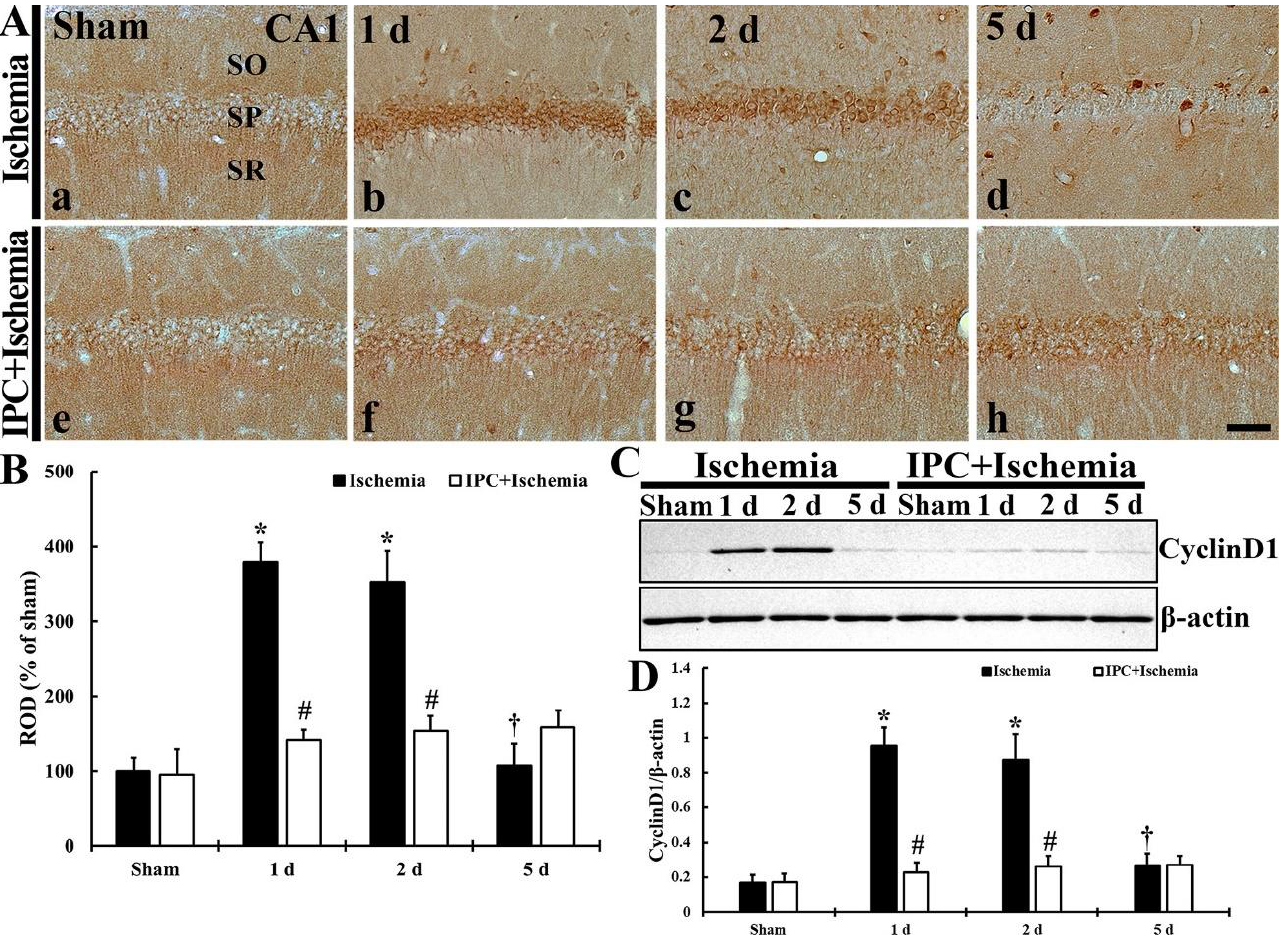
Figure 3. ( A ) Immunostaining of cyclin D1 in CA1 of the TI (upper column) and IPC+TI (lower column) groups at sham (a,e), 1 day (b,f), 2 days (c,g), and 5 days (d,h) after TI. Cyclin D1 immunoreactivity is increased in pyramidal cells located in the stratum pyramidale (SP) at 1 and 2 days after TI. In the IPC+TI group, cyclin D1 immunoreactivity is similar to that found in the sham group. SO, stratum oriens; SR, stratum radiatum. Scale bar = 50 µ m. ( B ) Quantitative graph of cyclin D1 immunoreactivity in pyramidal cells. Relative optical density (ROD) was calibrated as percent with the sham (100%). The bars represent means ± SD ( n = 7, * p < 0.05 versus sham group; # p < 0.05 versus TI group; † p < 0.05 versus prior time point of each group). ( C ) Western blot of cyclin D1 (37 kDa) in CA1 of the sham, TI, IPC+sham and IPC+TI groups at 1, 2, and 5 days after TI. β -actin was used as a protein loading control. ( D ) Relative band intensity of total cyclin D1 level. Cyclin D1 level is significantly low in the IPC+TI group compared with the TI group. The bars represent means ± SD ( n = 7, * p < 0.05 versus sham group; # p < 0.05 versus TI group; † p < 0.05 versus prior time point of each group).